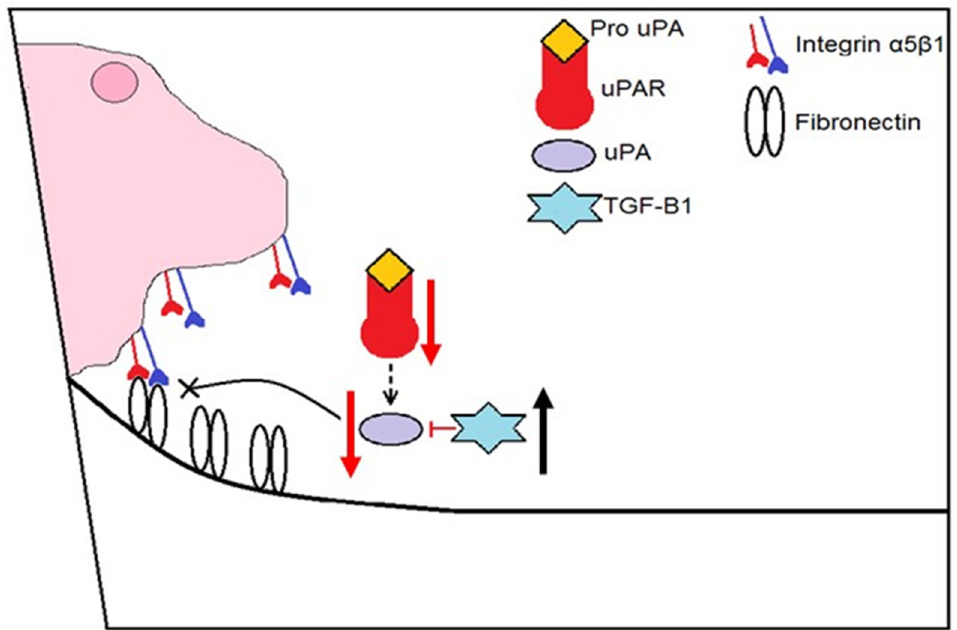
Figure 10. Schematic summarizing the effects of T β 4 + ciprofloxacin on fibronectin, ITG α 5 β 1, uPA, uPAR, and TGF- β 1 during wound healing leading to successful migration of corneal epithelial cells (CEC) across the extracellular matrix (ECM).